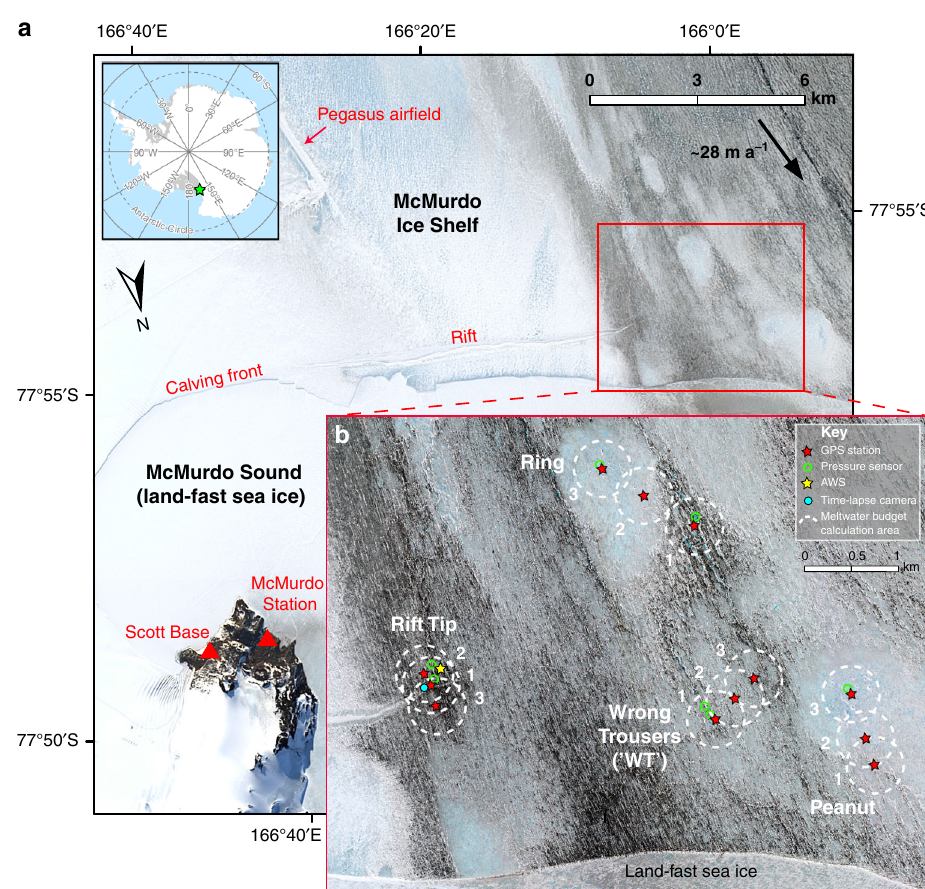
Fig. 1 Study site on the McMurdo Ice Sheet in the vicinity of McMurdo Station and Scott Base. The background of both a and b is a WorldView-2 image (©2016, DigitalGlobe) dated 2 December 2016. In a , the green star in the top-left inset indicates the location of the McMIS, and the black arrow indicates the local ice fl ow direction and speed ( ∼ 335° True at ∼ 28 m a − 1 ), based on our own GPS velocity data from the 2016/2017 austral summer. The red box indicates the location of our study site, shown in b , in which the four lake sites are labelled. At each lake site, the locations of three GPS stations are marked with red stars (labelled 1 to 3, where 1 is closest to the lake centre and 3 is furthest away). Green open circles mark the locations of pressure sensors; data from three of these are shown in Figs. 3 and 4. A yellow star marks the location of the automatic weather station (AWS), and a blue circle marks the location of a time-lapse camera (used to produce Supplementary Movie 1 and Supplementary Fig. 1). The dashed-white circles of r = 250 m, centred on each of the 12 GPSs, show the areas where seasonal meltwater budgets were calculated. (N.B. Rift Tip lake was originally named in a previous (2015/2016) fi eldwork season, when it was at the end of a rift. Although this rift has since propagated westwards by ~3 km (ref. 21 ), we have kept the original